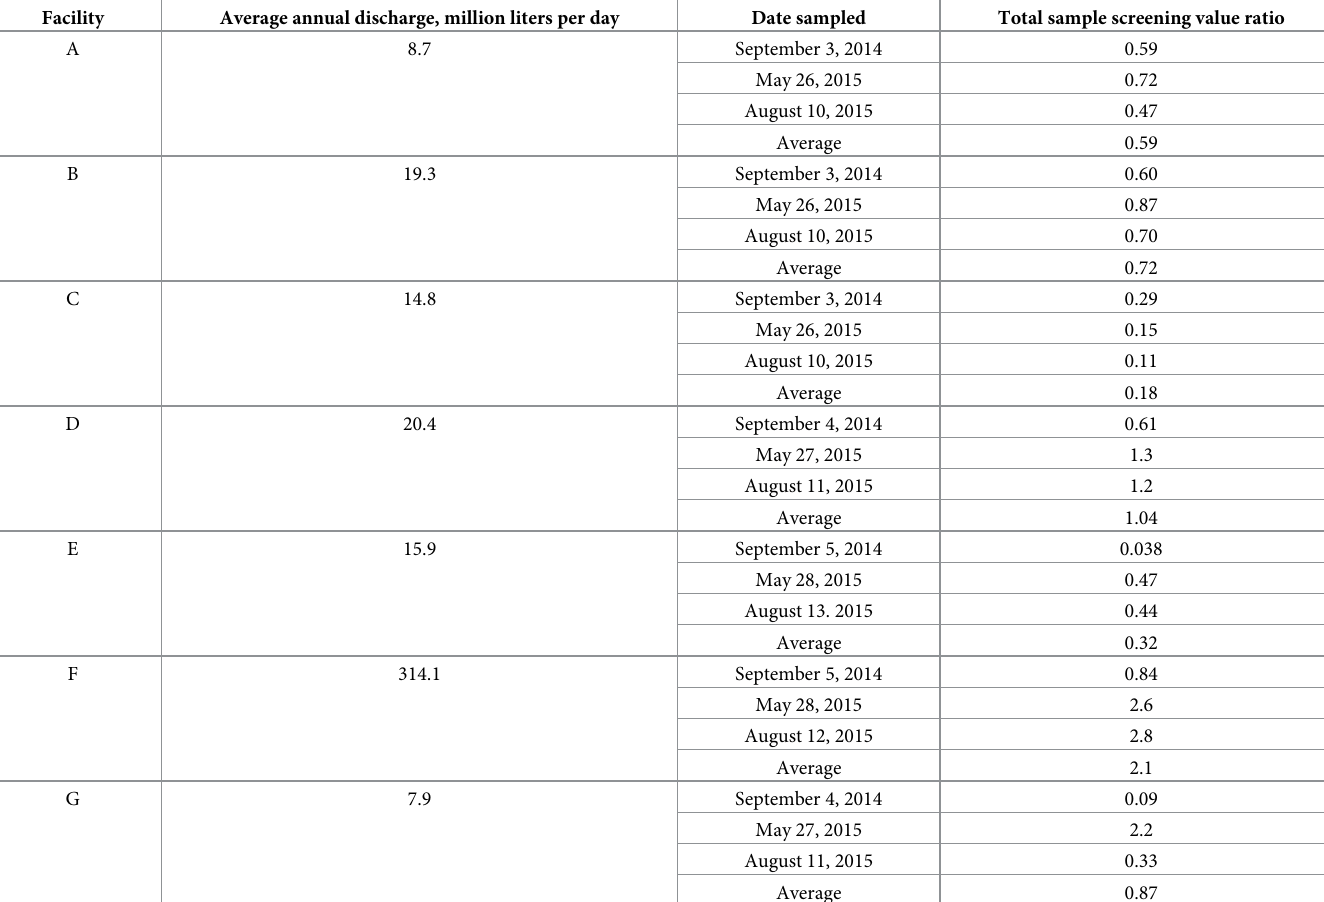
Table 4. Total sample screening value ratios for pharmaceuticals detected in groundwater downgradient from subsurface treatment systems in Central Minnesota, 2014–2015.